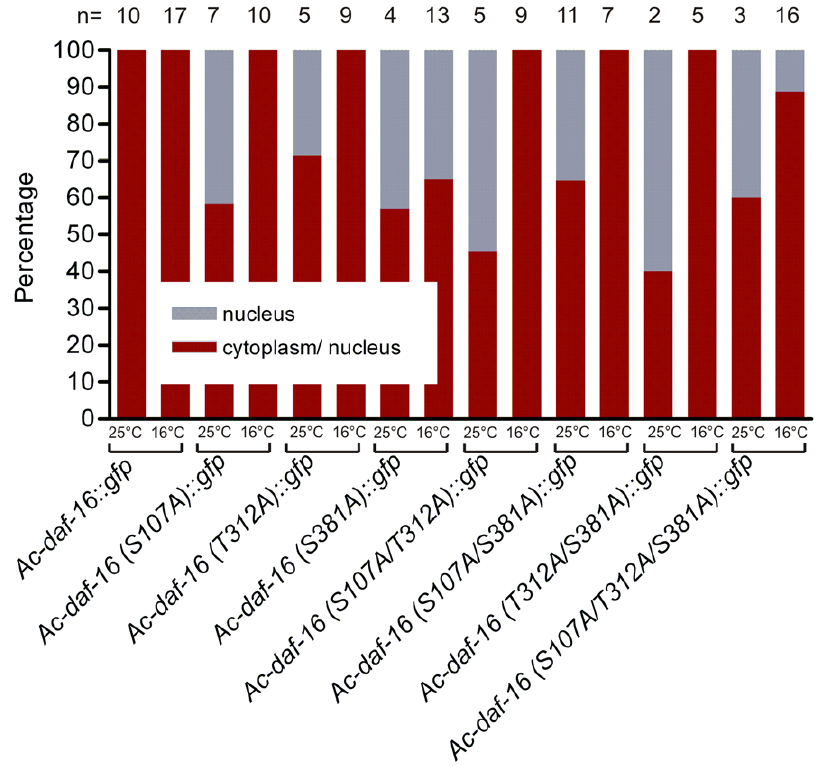
Figure 7. Quantified sub-cellular localization of Ac -DAF-16 wildtype and AKT-phospho-mutants in dauer larvae. Dauer larvae showing nuclear and nuclear/cytoplasmic Ac -DAF-16::GFP were quantified during dauer and following induction of dauer exit.